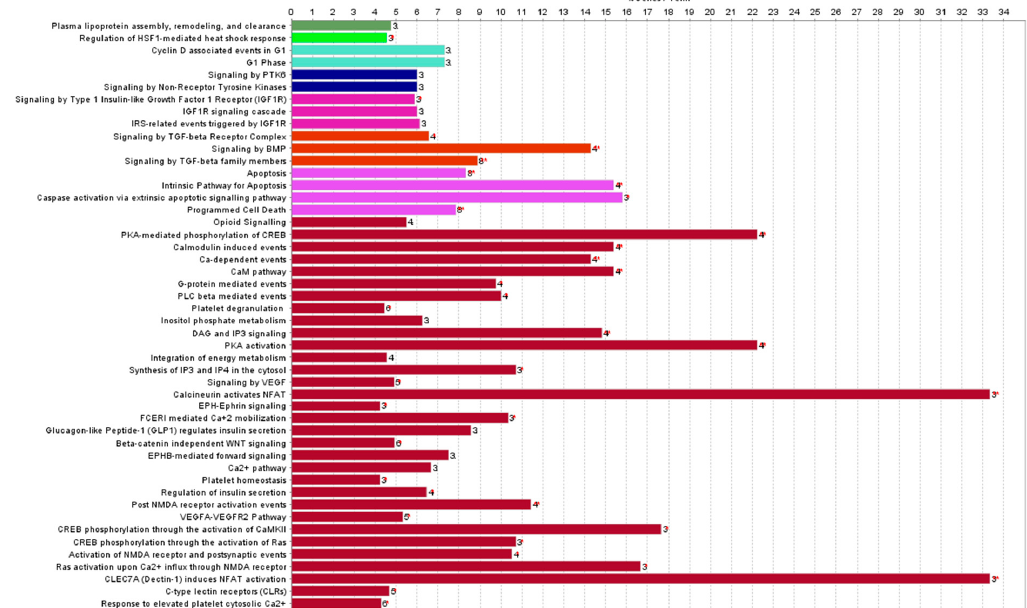
Figure 4. Histogram showing the most significant REACTOME pathways associated with the statistically significant miRNAs in common between PBI and WBI mouse hearts (listed in Table 2). The single line represents specific gene ontology (GO) terms obtained from the ClueGo analysis. The colors indicate specific clusters of the differentially expressed genes between PBI and WBI samples. Red asterisks refer to significance in the percentage of pathway deregulation (* p < 0.05, ** p < 0.01).